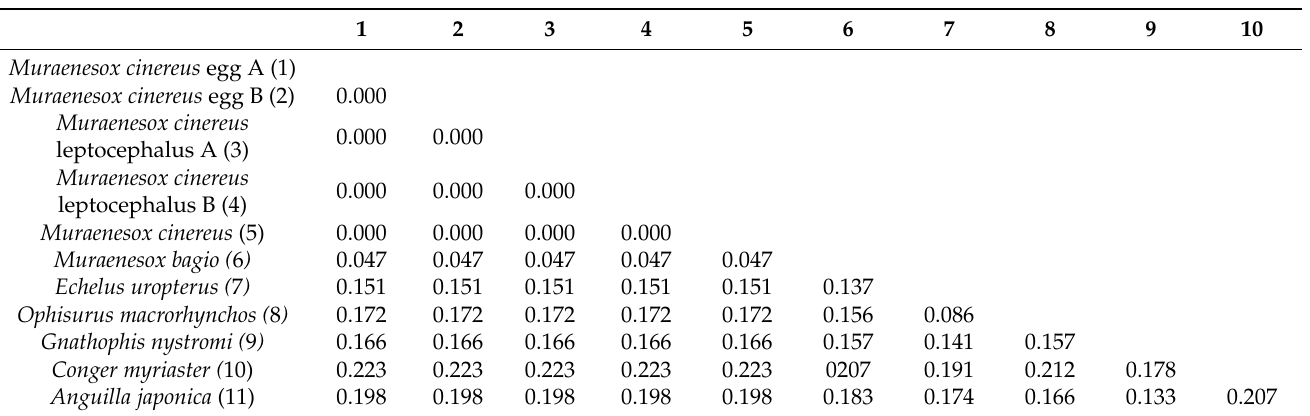
Table 2. Genetic distance among Muraenesox cinereus eggs, preleptocephalus, and six other Anguilli- formes